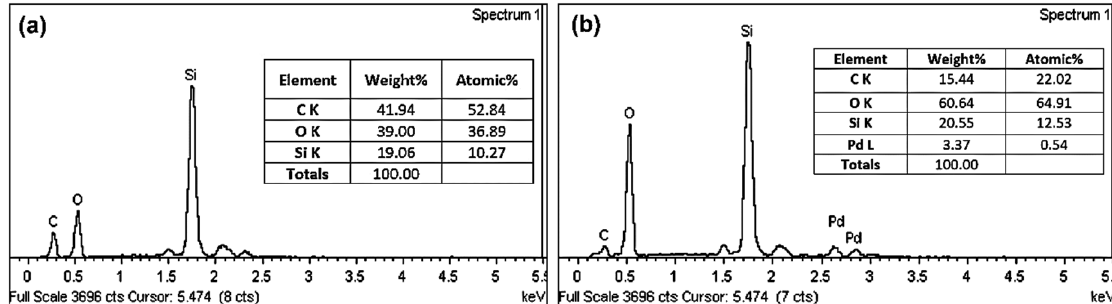
Figure 9. EDX measurement of ( a ) GO and ( b ) Pd/GO nanocomposite.